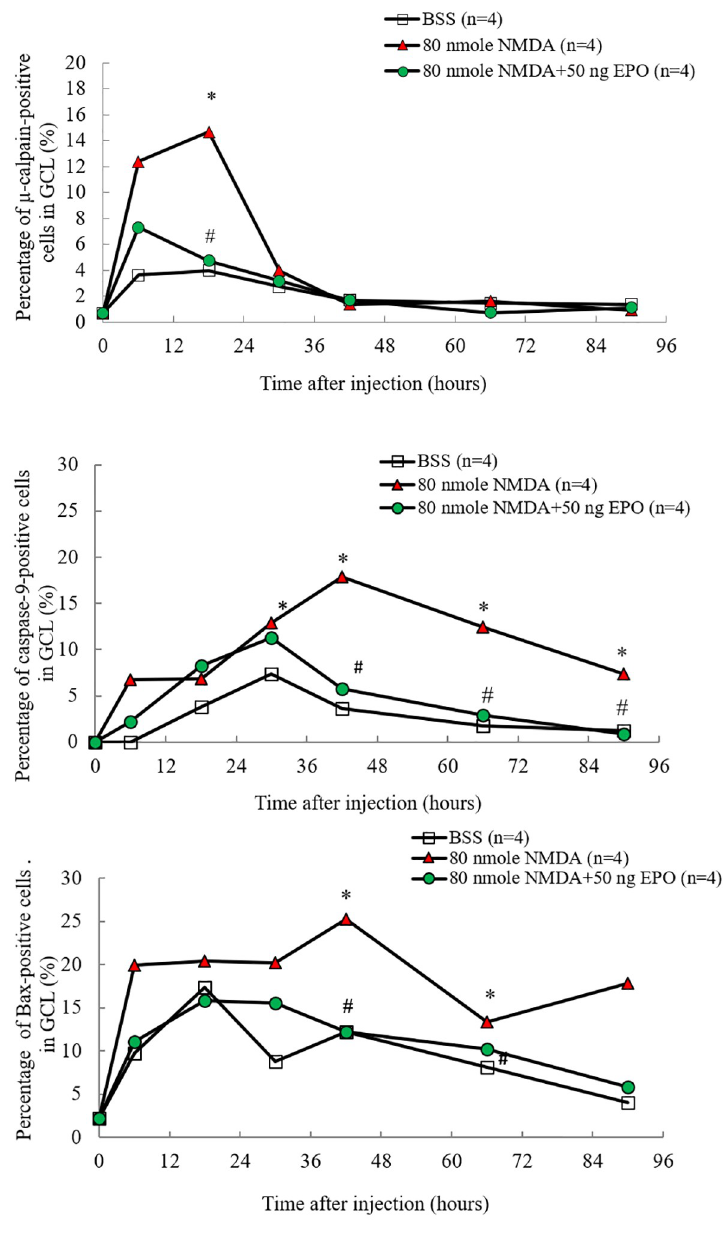
Fig 6. Immunohistochemical staining of μ -caplain-, caspase-9-, and Bax-positive on ganglion cell layers (GCL) of Wistar rats: The images were obtained at 0, 6, 18, 30, 47, 66, and 90 hrs after receiving the intravitreal injection of (1) 2 μ L BSS only, (2) 80 nmoles NMDA, and (3) 80 nmoles NMDA + 50 ng EPO. The median percentage of positive cells were represented (n = 4), compared with baseline levels ( � p < 0.05) and compared with NMDA- mediated group (#p < 0.05). (Data were derived from S1, S2 and S3